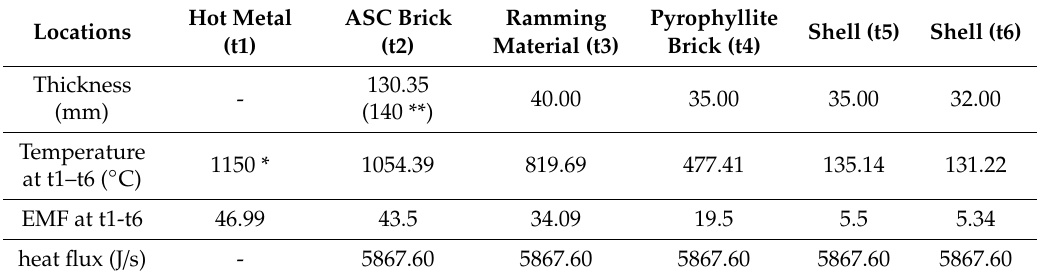
Table 1. Results of torpedo ladle thickness (t1 to t6 reference to Figure